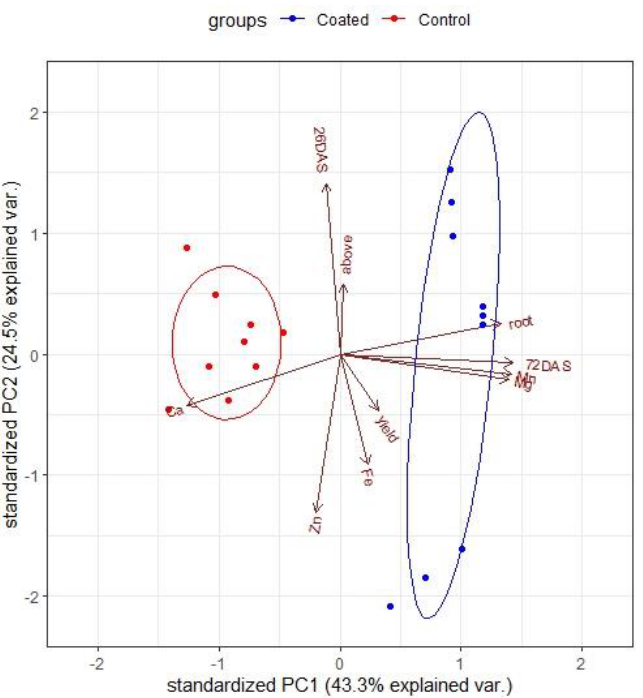
Figure 2. Principal components analysis of soybean yields and nutrition properties between seed coated and control treatments. Above; above ground biomass, root; root biomass, yield; soybean grain yield, 26DAS; SPAD value of 26 days after seedling, 72DAS; SPAD value of 72 days after seedling.